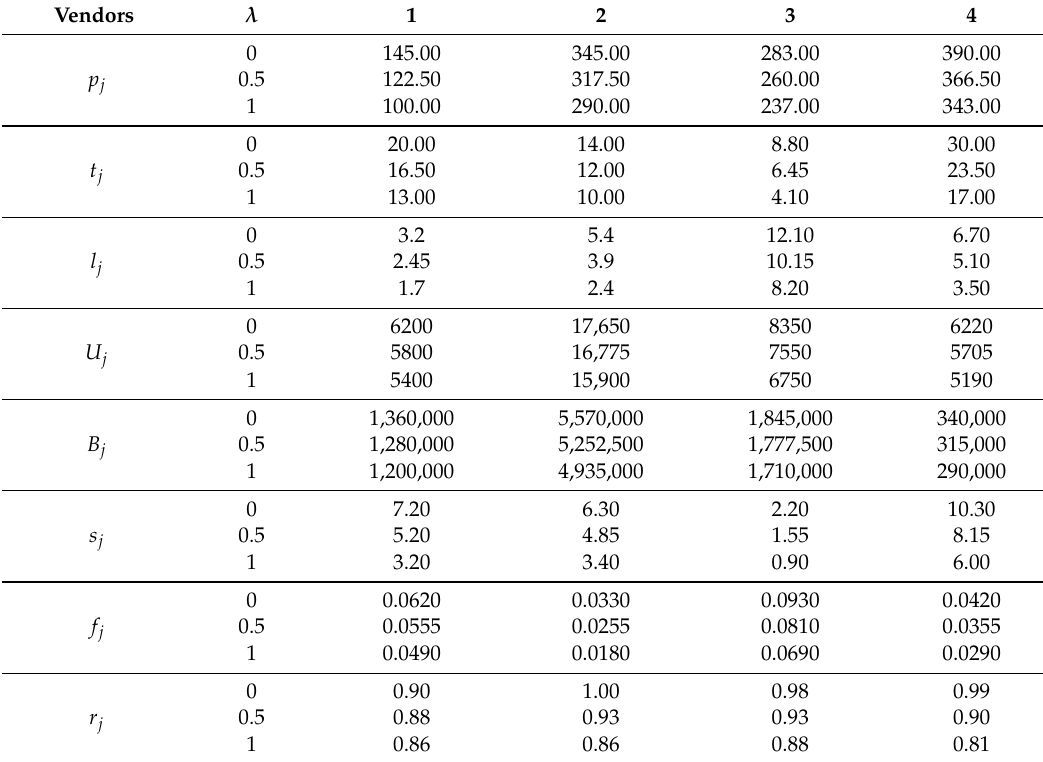
Table 5. Optimistic, pessimistic and most likely value of the fuzzy parameter for case